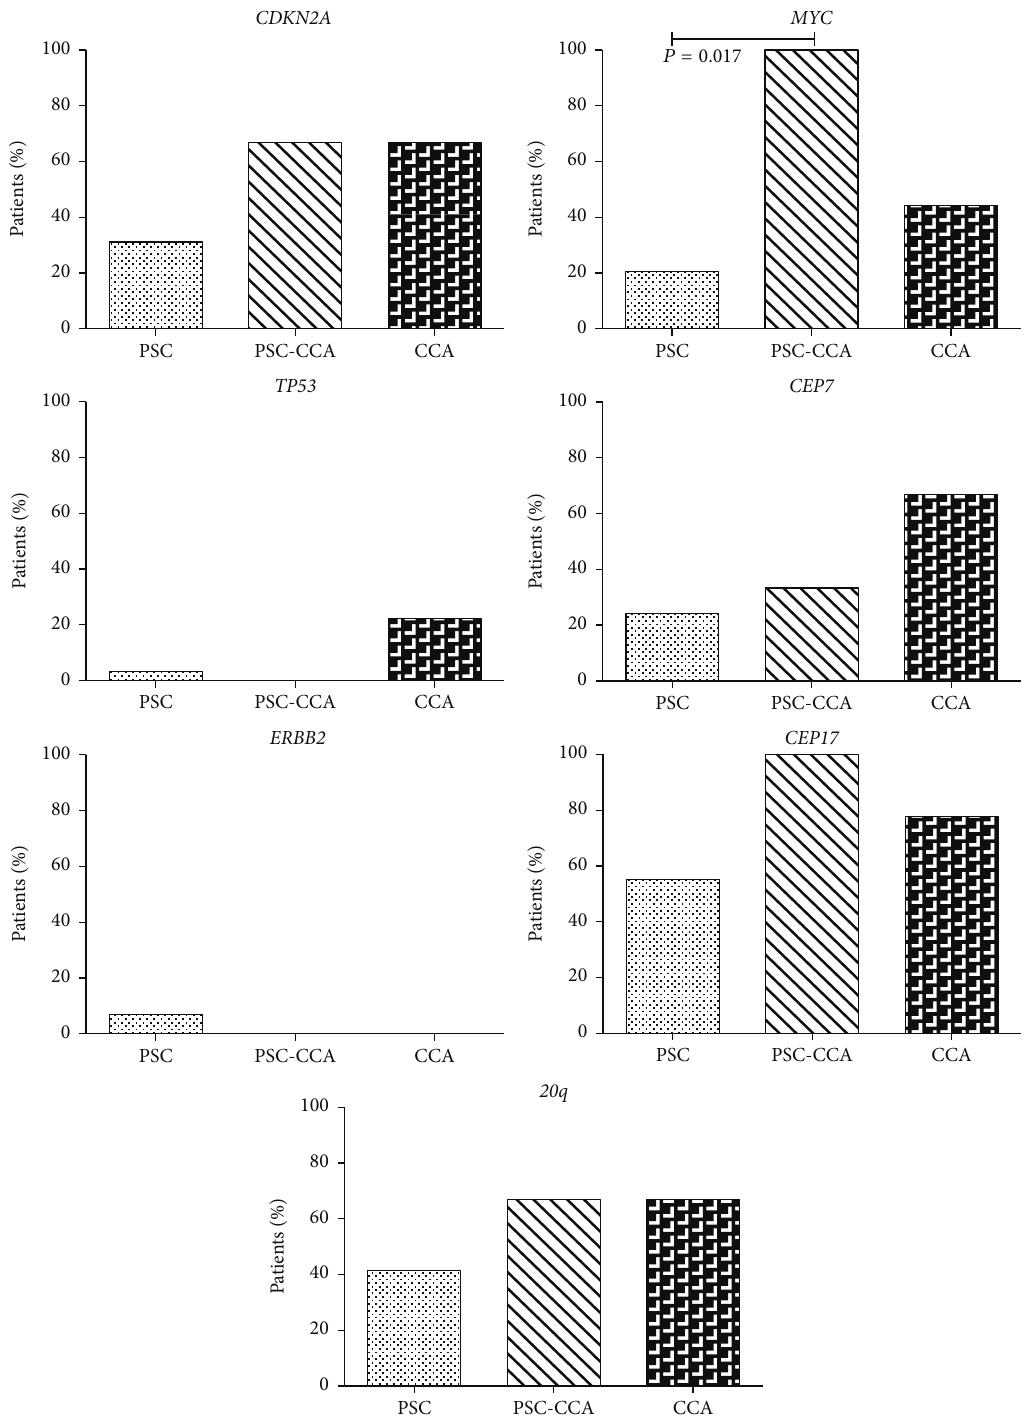
Figure 2: Genetic abnormalities in PSC, PSC-associated CCA, and sporadic CCA. 𝑃 values are compared using Fisher’s exact test.